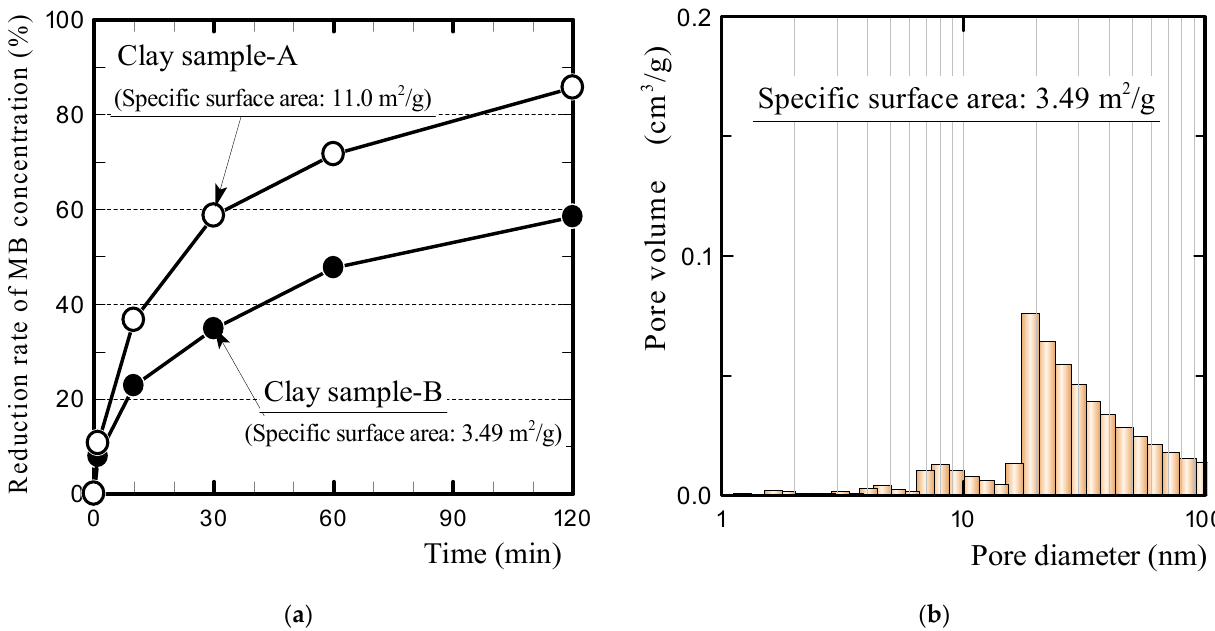
Figure 12. ( a ) Comparison of the MB concentration reduction rates for clay ceramics with different specific surface areas and ( b ) pore size distribution of clay sample B. Table 6. Apparent porosity, specific surface area, and carbon content of POM/clay ceramic.